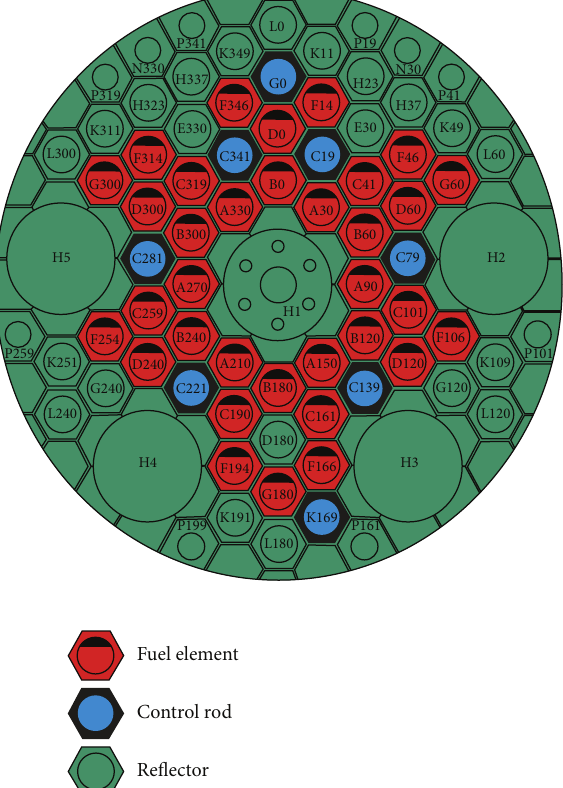
Figure 1: Horizontal cross-section of BR2 with a typical loading [2].